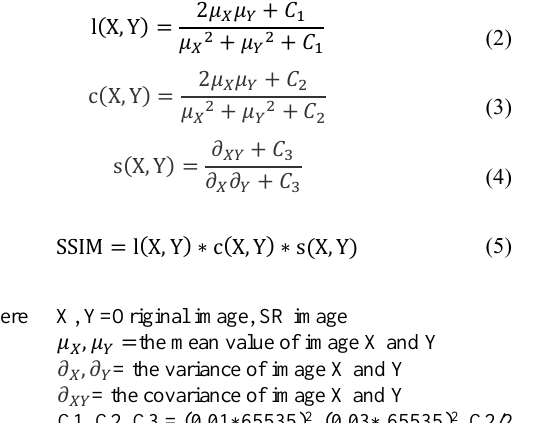
Figure 3. Daily average passive microwave brightness temperature data with the polar stereographic grids of NSIDC X(i,j) = the pixel value of original image Y(i,j) = the pixel value of SR image SSIM measures image similarity from brightness (equation (1)), contrast (equation (2)) and structure (equation (3)). The SSIM value range is (0,1). Higher value indicates a smaller distortion of the image. It can better reflect the subjective feelings of the human